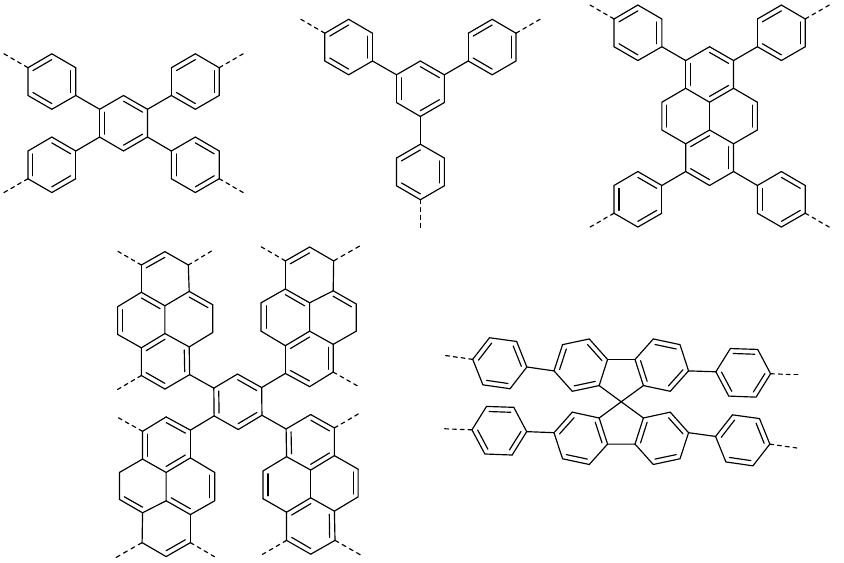
Figure 25. CMP structures first utilized for photocatalytic hydrogen production. Please note that the structures are much more complex than these simple representations due to their 3D nature as well as a large number of defects and end-groups [121,122].